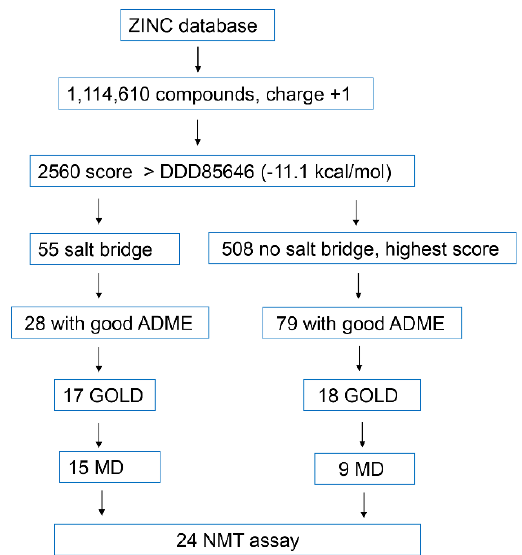
Figure 3. A workflow chart of the virtual screening. Over 1.1 million structures with a charge of +1 were downloaded from the ZINC database. By using AutoDock Vina, 2560 compounds were identified that had a higher AutoDock affinity score than the score of the potent NMT inhibitor, DDD85646 ( − 11.1 kcal/mol). Of them, 55 were found to form a salt bridge with the C-terminus of NMT. In parallel, 508 of the highest scoring ligands that did not participate in a salt bridge with the C-terminus of NMT were also analyzed. Filtering the compounds based on their ADME properties narrowed down the number of compounds to 28 and 79, respectively. These compounds were used for docking using GOLD software, and the best scoring 35 were selected (17 that form a salt bridge and 18 that do not). Molecular Dynamics (MD) was performed on the NMT complexes of these 35 ligands, and finally, 24 compounds were selected for experimental testing in an in vitro fluorescent NMT assay. The group that did not form a salt bridge with the C-terminus of NMT, comprised two types of compounds: some that formed a hydrogen bond with the C-terminus of NMT and some that did not interact with the C-terminus at